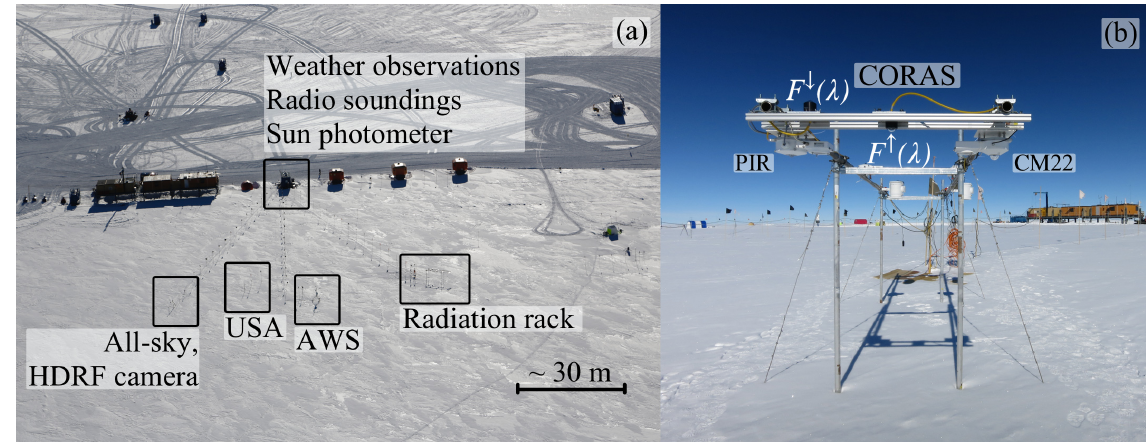
Figure 2. (a) Aerial photograph of Kohnen station. The positions of different ground-based instruments are marked with black rectangles. USA: ultrasonic anemometer. AWS: automatic weather station. (b) Instrument setup at the ground-based radiation rack: optical inlets of the CORAS instrument and the broadband radiation instruments CM22 and PIR. Table 1. List of instruments operated on ground and on Polar 6 aircraft.